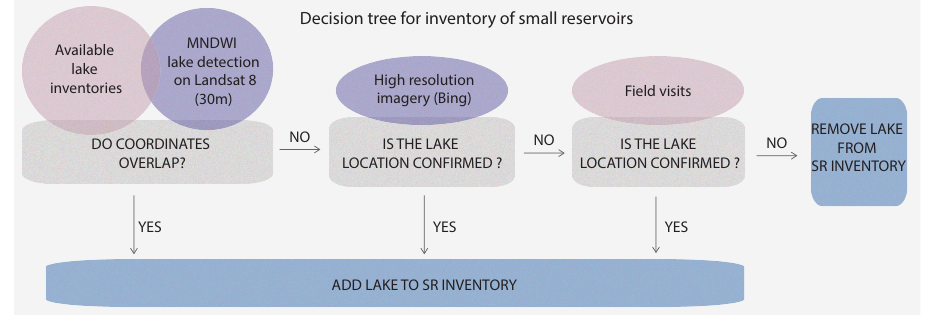
Figure 3. Decision tree for the inventory of small